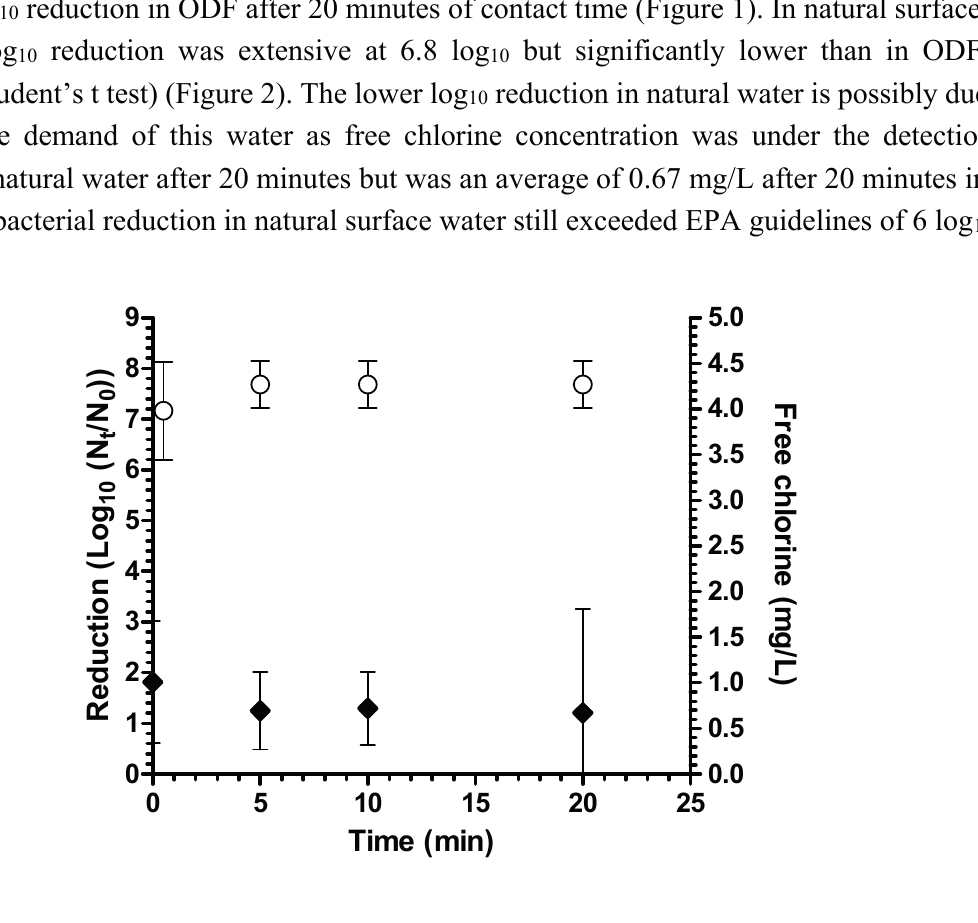
Figure 1. Reduction of A. hydrophila in ODF buffer ( n = 4 experiments) (white circles = bacterial reduction; black diamonds = free chlorine residual; bars = 95% confidence